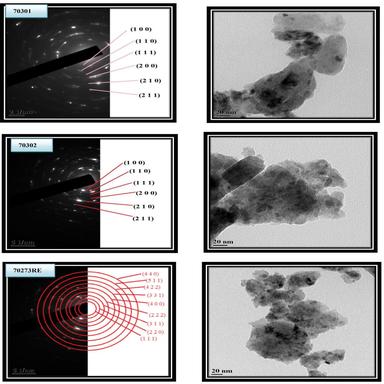
TEM images and particle size distribution all four NEG alloys.